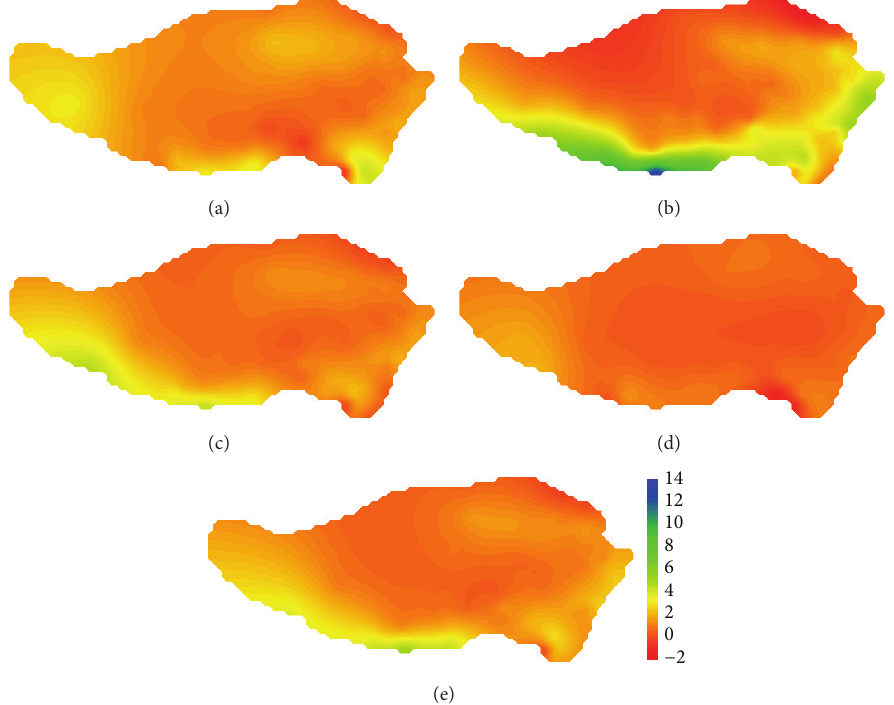
Figure 9: Comparison of the values of precipitation on the Tibetan Plateau in reference period between GFCM21’s simulation and observation: (a) spring; (b) summer; (c) fall; (d) winter; (e)